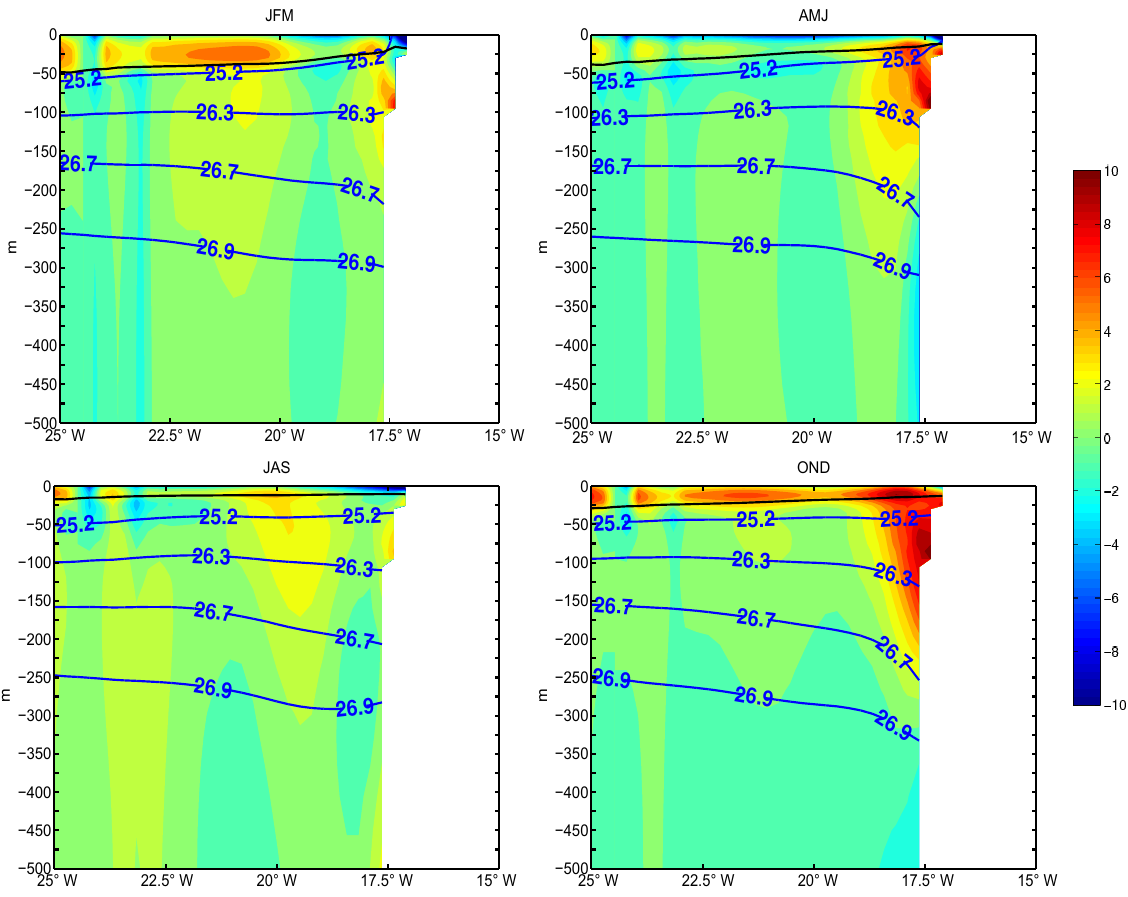
Figure 7. Seasonally averaged vertical–zonal section of meridional velocity (in colors; cms − 1 ), σ t (blue lines; kgm − 3 ), and mixed layer depth (black line; in meters) averaged between 13 and 15 ◦